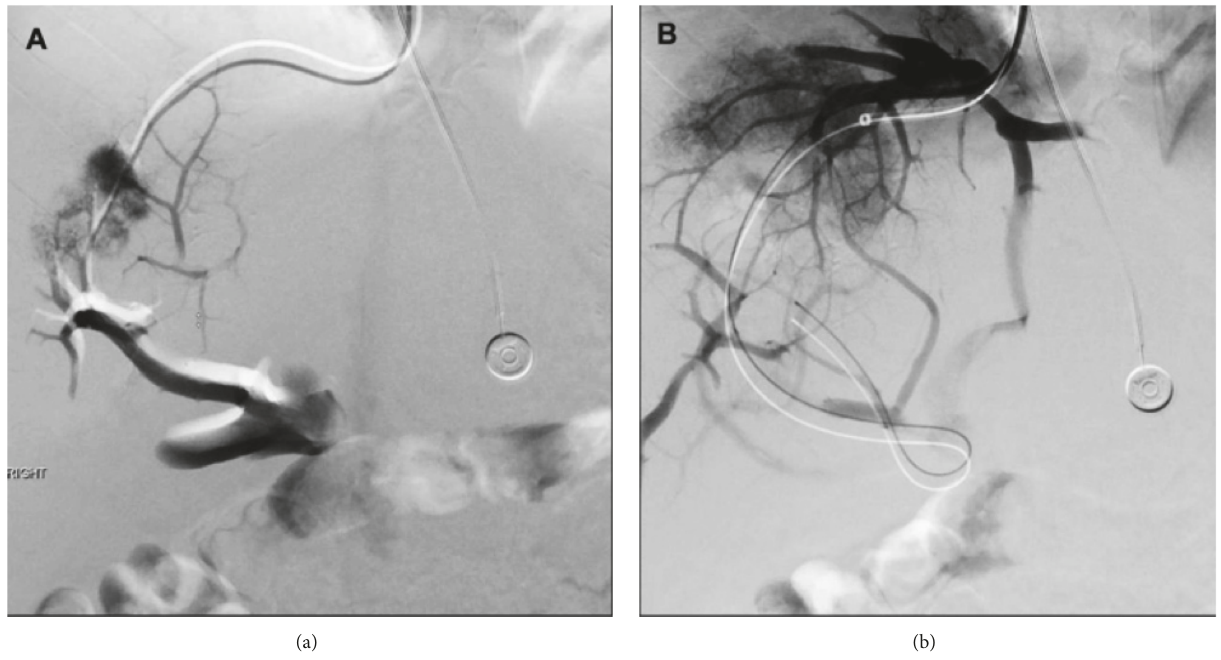
Figure 1: (a) Initial venography of right hepatic venous system. Note parenchymal blush and opacification of the hepatic veins and portal venous system. (b) Venography following distal placement of the guidewire. Note the guidewire is now within the portal venous system. Parenchymal blush can be seen as well as opacification of the hepatic venous system and multiple collaterals leading, from the hepatic venous system to the portal